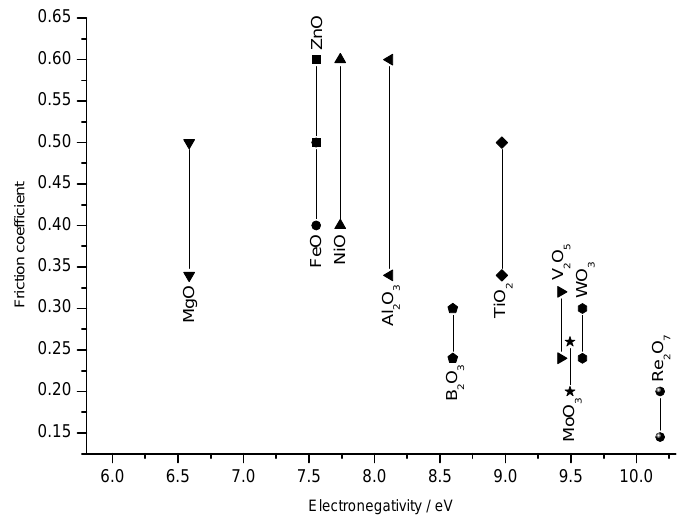
Figure 6. Relationship between friction coefficients and electronegativity of certain solid oxides with coordination number of 6. (Data of friction coefficient of solid oxides are from Ref. [1].)